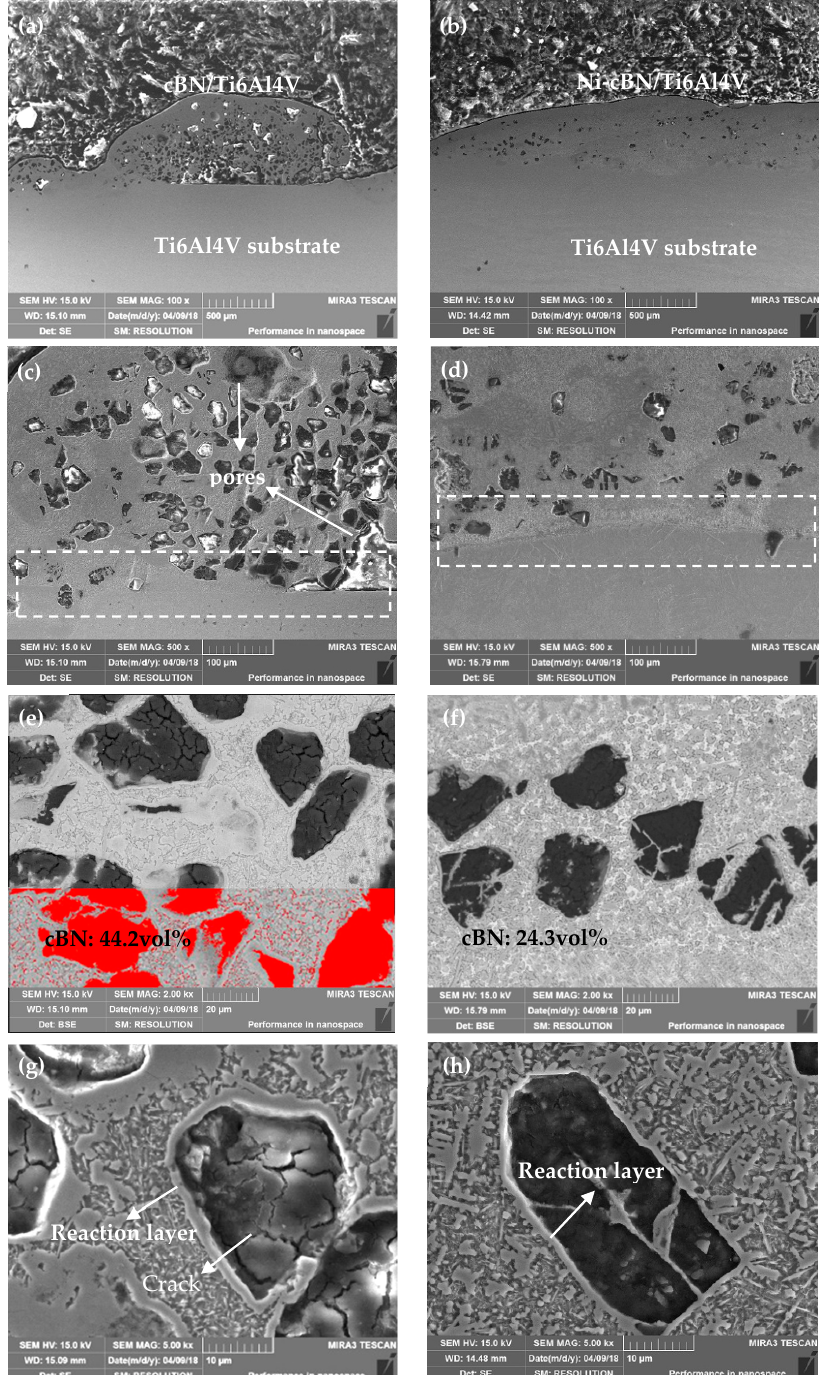
Figure 3. Cross-sectional SEM images of the LC cBN/Ti6Al4V and NicBN/Ti6Al4V composite coatings: ( a ) Macroscopic image of the cBN/Ti6Al4V coating; ( b ) macroscopic image of the NicBN/Ti6Al4V coating; ( c ) interface of the cBN/Ti6Al4V coating; ( d ) interface of the NicBN/Ti6Al4V coating; ( e ) backscattered electron (BSE) image of the cBN/Ti6Al4V coating; ( f ) BSE image of the NicBN/Ti6Al4V coating; ( g ) cBN particles in the cBN/Ti6Al4V coating; and ( h ) cBN particles in the NicBN/Ti6Al4V coating.